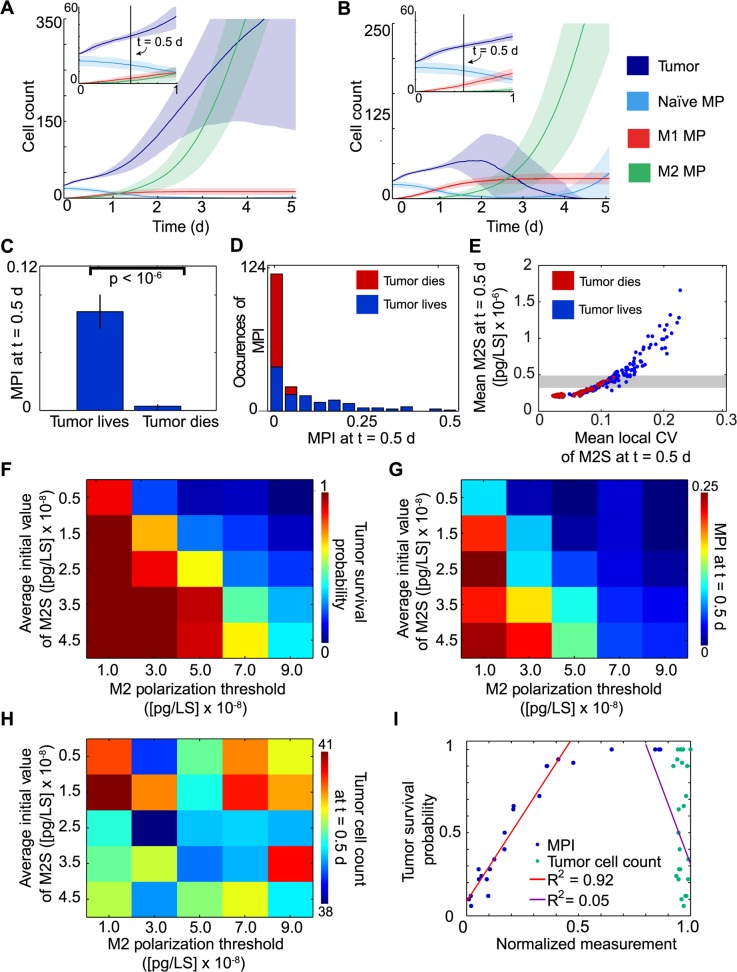
Functional and spatial predictors of tumor clearance.The model was run 200 times at base parameter values, and runs were grouped based upon simulation outcome (tumor survival or tumor death). (A,B) Time evolution of cell counts (by type) for runs in which the tumor survived (A) or died (B). Insets: Expanded views of early time points (same axes). (C) Macrophage polarization index (MPI) at 0.5 d post tumor-initiation, classified by simulation outcome. Error bars indicate standard error. (D) Distributions of MPI at t = 0.5 d observed across multiple simulations, classified by outcome. (E) Spatial metrics of the TME at t = 0.5 d: domain-wide maximum M2S value and mean local coefficient of variation (CV) of M2S, classified by outcome. Local CV of M2S was calculated within each 10 x 10 lattice site (LS) array, and mean of all 100 such arrays across the domain is shown. (F) Tumor survival probability evaluated across variations in average initial M2S level (p11) and M2 polarization threshold (p13). (G) MPI at t = 0.5 d evaluated across the same parameter variations used in F. (H) Tumor cell counts at t = 0.5 d evaluated across the same parameter values used in F. (I) Normalized MPI (blue) and normalized tumor cell count (green), both at t = 0.5 d, calculated across the same parameter values used in F and plotted against tumor survival probability. Linear regression was performed on data points for which tumor survival probability was less than 1.